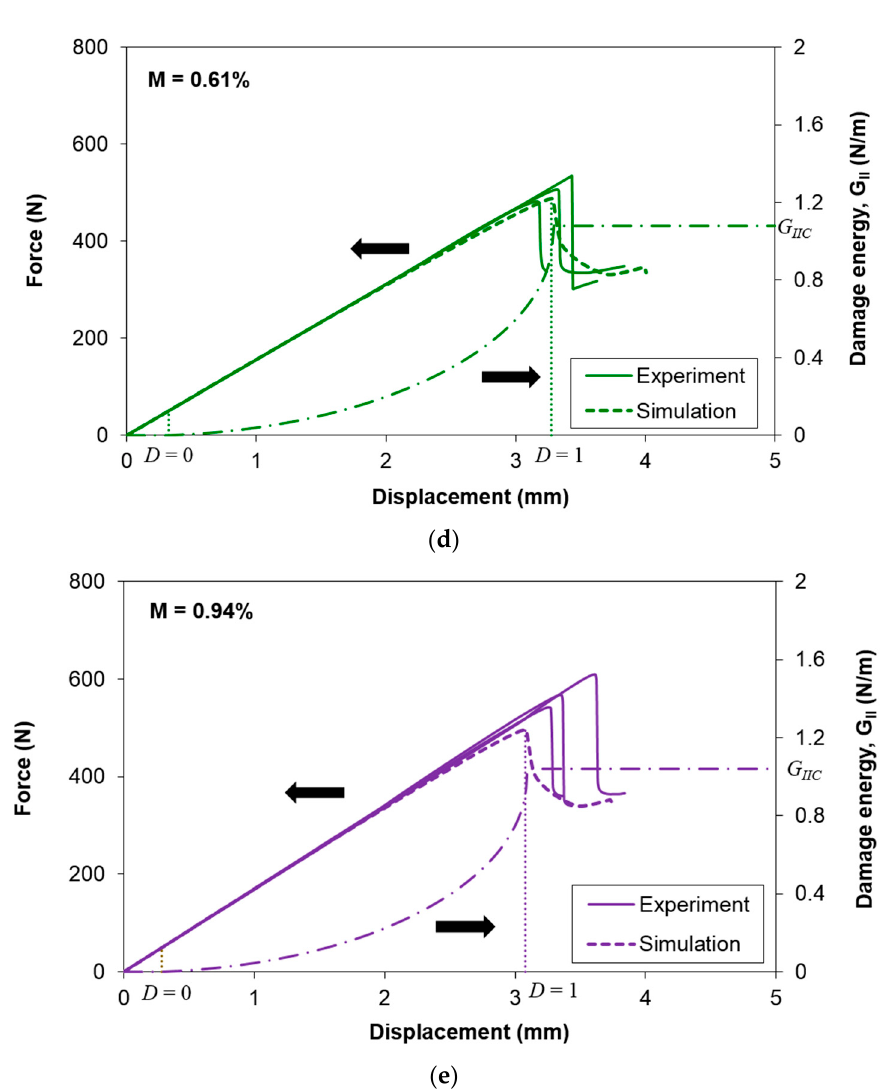
Figure 10. Experimental and numerical force displacement curves at moisture content of ( a ) 0%, ( b ) 0.23%, ( c ) 0.42%, ( d ) 0.61%, and ( e ) 0.94%, along with the evolution of the damage energy.